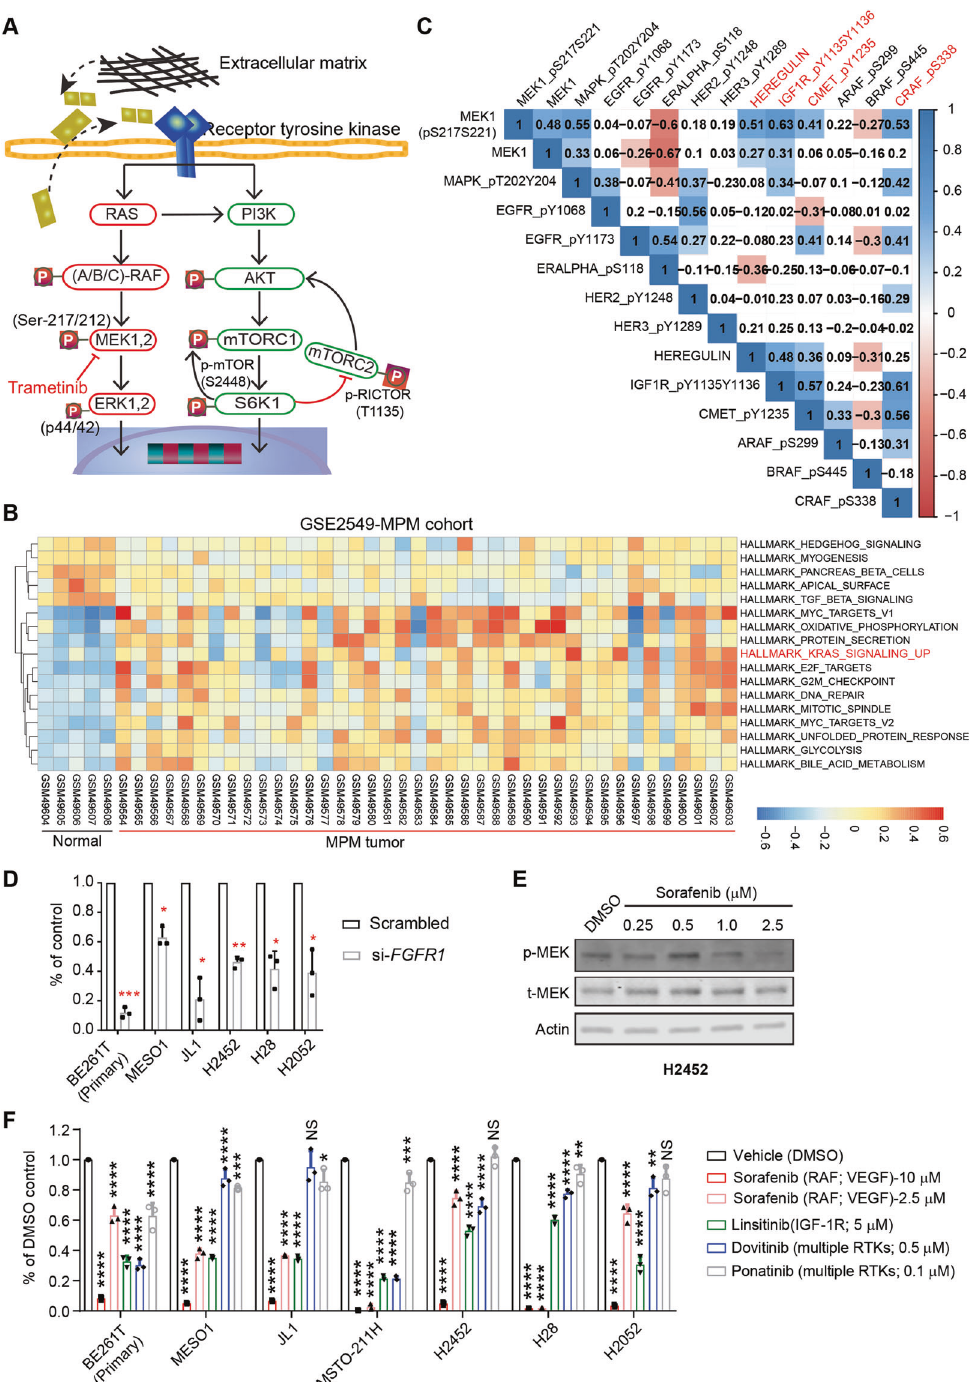
Fig. 2 Molecular mechanisms underlying MAPK hyperactivation in MPM. A Schematic of the RAS-RAF-MEK-ERK and the mTOR pathway downstream of RTK signaling. B Gene set variation analysis (GSVA) shows deregulation of the Hallmark modules in MPM tumors compared with normal pleural tissue. The transcriptomic data of MPM samples (GSE2549 dataset) were downloaded from the Gene Expression Omnibus (GEO). Note that the KRAS_signaling_UP signature is signi fi cantly enriched in MPM tumors vs. normal pleural tissue. C The RTK pathway proteins (p-IGF1R, p-CMET, HEREGULIN) and the MAPK pathway proteins (p-CRAF, p-MAPK/p-ERK) correlate strongly and positively with p-MEK1 (Ser217/221) in MPM. The numbers in the correlogram indicate the correlation coef fi cient (Spearman), with signi fi cant ( P < 0.05) positive and negative correlations shown in blue and red, respectively. The color intensity is proportional to the correlation coef fi cient, with a non-signi fi cant ( P > 0.05) correlation in the blank background. D Viability assay of the indicated MPM cells transfected (72 h) with FGFR1 - speci fi c or control siRNAs. * p < 0.05, ** p < 0.01, *** p < 0.001 by Welch ’ s t -test ( n = 3). E Immunoblots of H2452 cells treated for 12 h with the B/C-RAF inhibitor sorafenib. Note that 2.5 µM sorafenib effectively blocked MEK signaling (decrease in p-MEK). F Viability assay of the indicated MPM cells treated for 96 h with clinically relevant doses (maximal plasma concentration in patients) of the indicated inhibitors. Data are shown as mean ± s.d. ( n = 3). * p < 0.05, ** p < 0.01, *** p < 0.001, **** p < 0.0001 by Welch ’ s t -test.